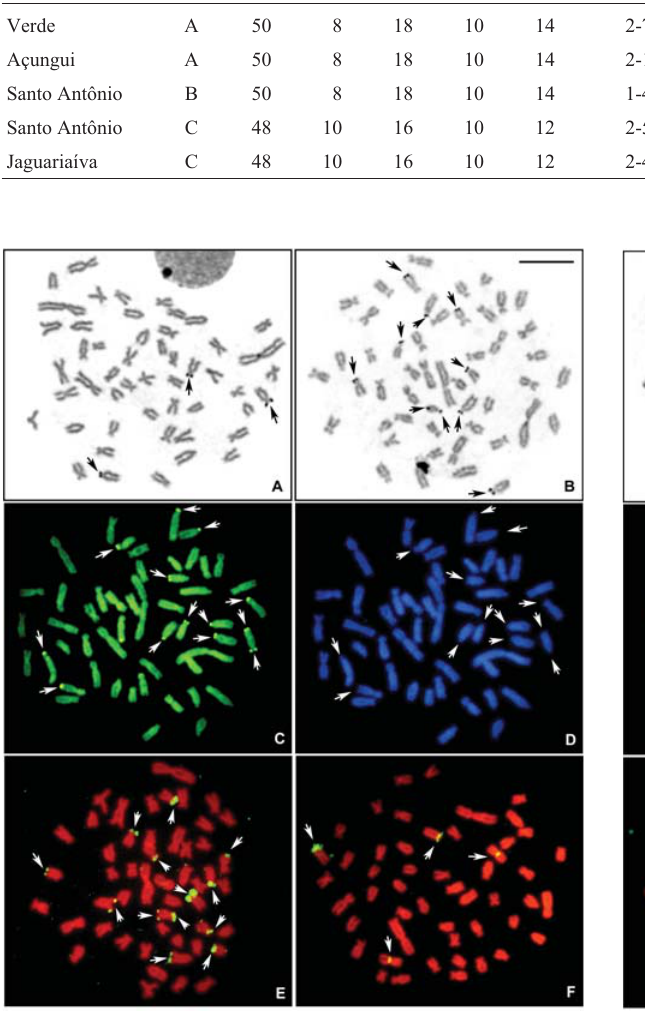
Figure 2 - Metaphases of the karyotypic form A ( Astyanax paranae ) evi- dencing (A, B) the Ag-NOR bearing chromosomes; (C) Chromomycin A 3 positive or GC-rich sites; (D) sequential DAPI negative or AT-negative sites; (E) the 18S rDNA sites, and (F) the 5S rDNA sites. Bar represents 10 μ m.